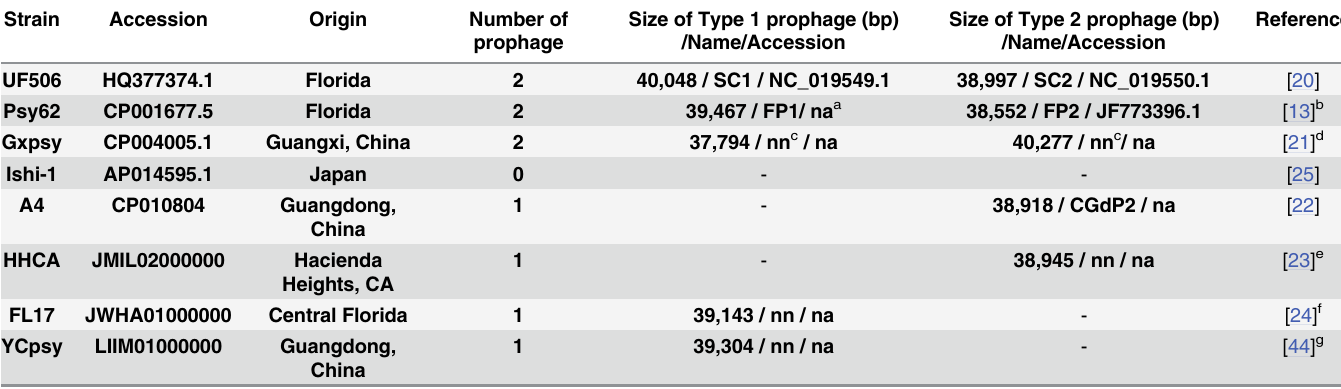
Table 1. General information of 8 published genome sequences of “ Candidatus Liberibacter asiaticus ” strains and their